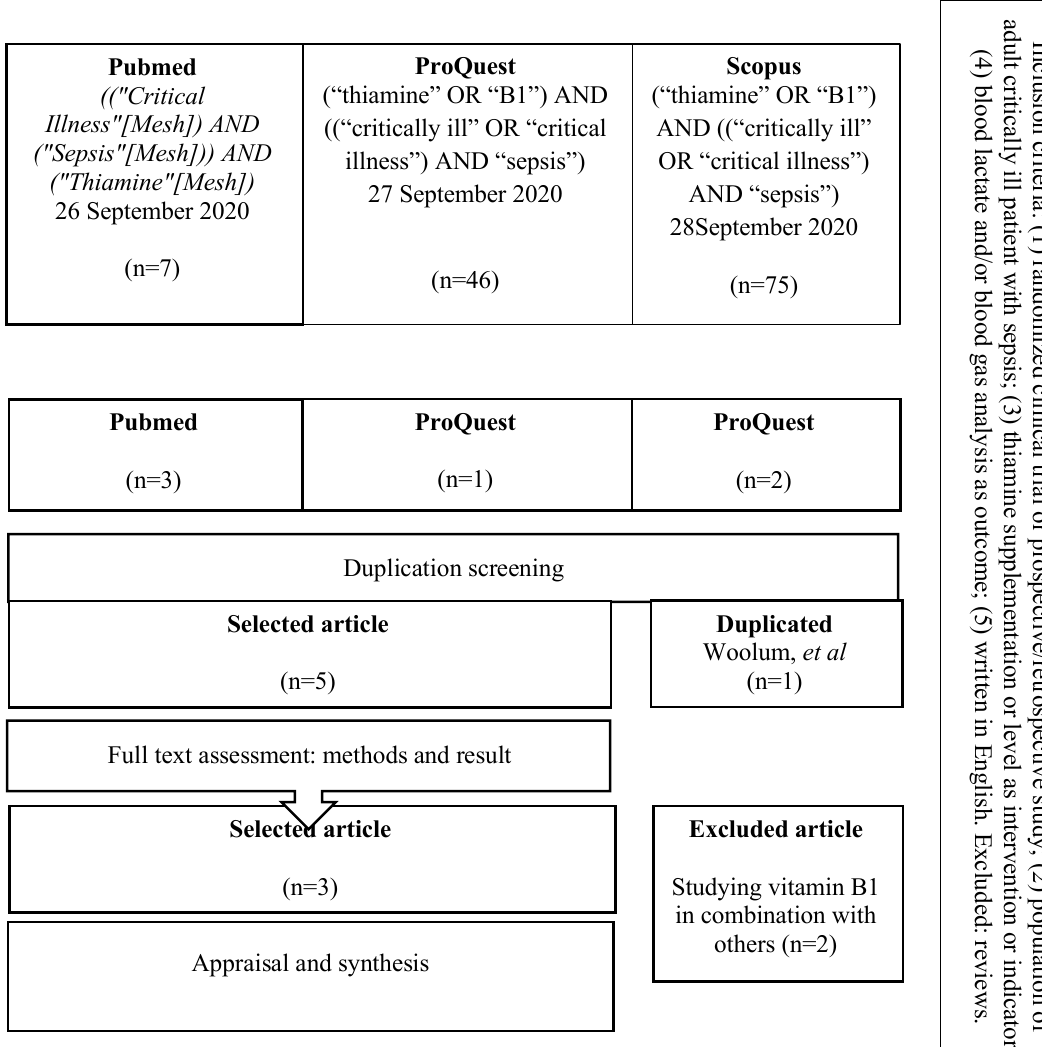
Figure 1. Literature searching